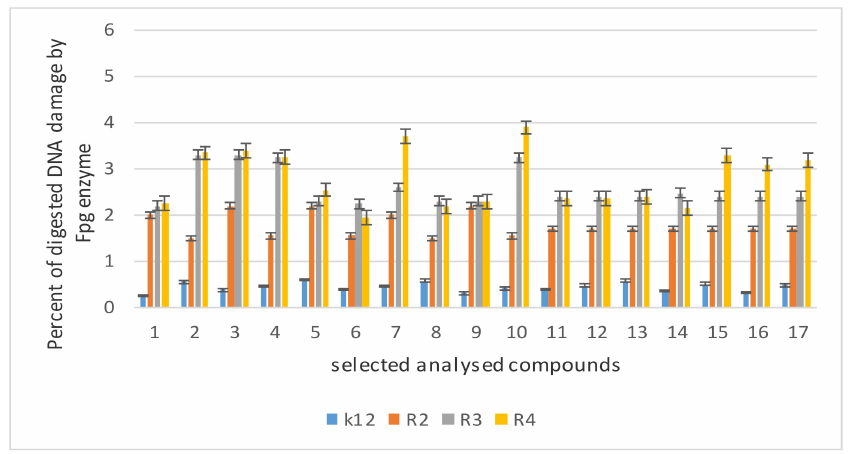
Figure 6. Percentage of plasmid DNA recognized by Fpg enzyme ( y -axis) with model bacterial, K12, and R2–R4 strains ( x -axis). The compounds numbered 2 , 3 , 4 , 7 , 10 , 15 , 16 , and 17 were statistically significant at <0.05